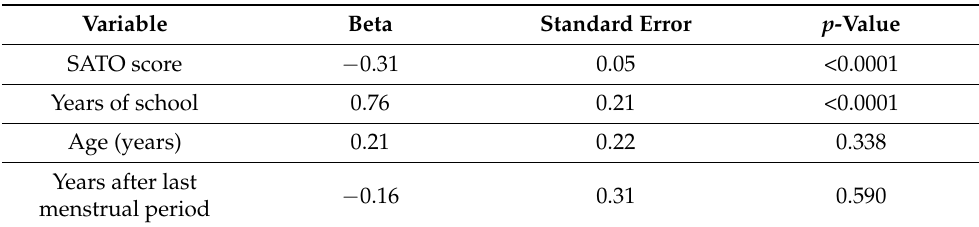
Table 4. Multivariate association between quality of life and self-perception of aging with other